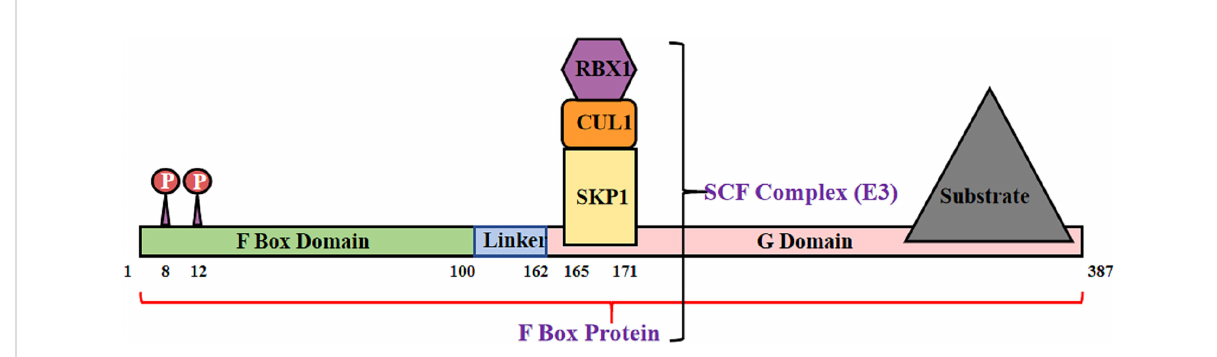
FIGURE 2 Structural diagram of FBX4. F box protein combine with Skp1, Cul1 and Rbx1, consisting SCF